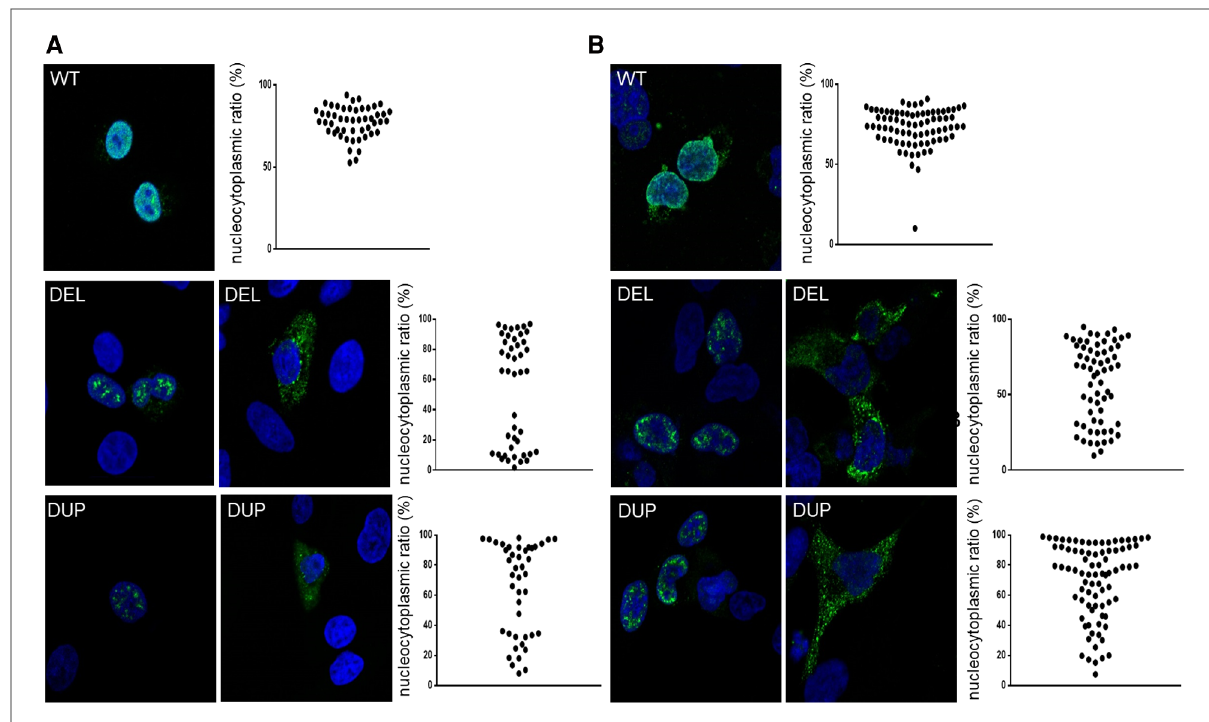
FIGURE 2 Representative confocal images of A549 cells ( A ) and nthy cells ( B ) after 24-h expression of NKX2-1 WT , NKX2-1 DEL and NKX2-1 DUP . Immunostaining involved incubation with rabbit polyclonal anti-NKX2-1 antibody (green). Nuclei were detected by ToPro-3 iodide (blue). Scatter graphs show the nucleocytoplasmic ratio of each protein ( ≥ 10 cells per experiment, n =3 or